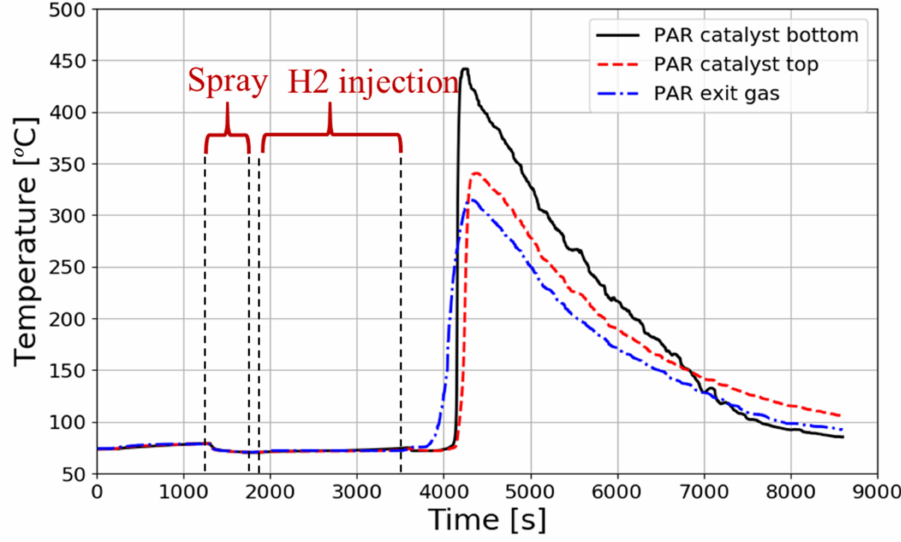
Figure 17. Variations in the catalyst and exhaust gas temperatures during the SSP3